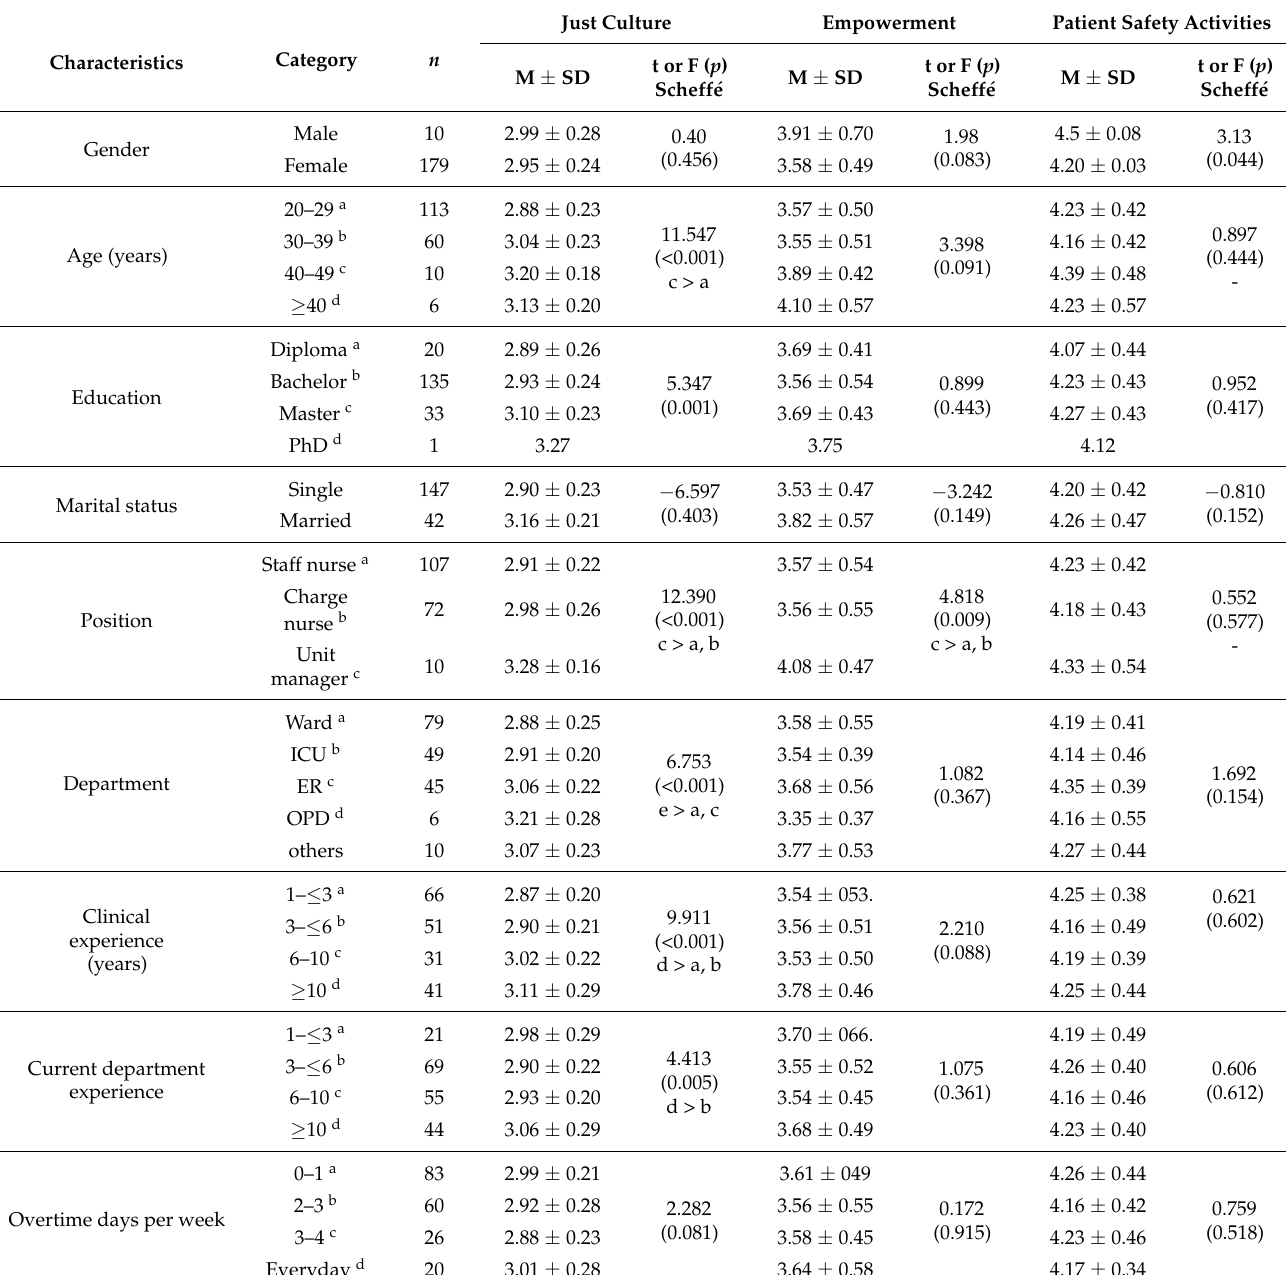
Table 2. Just culture, Empowerment and Patient Safety Activities by General Characteristics ( n = 189).